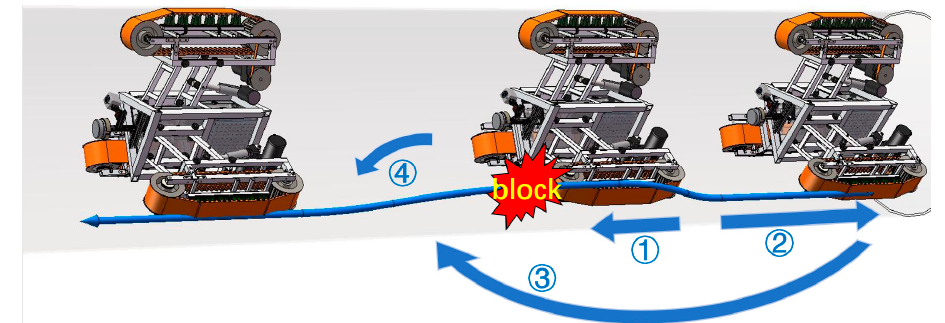
Figure 10. In-pipe robot passes indirectly through obstacles.